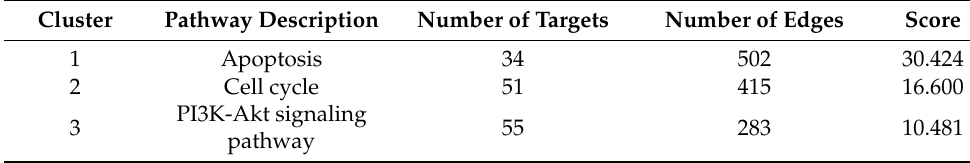
Table 2. Top 3 clusters identified from the MCODE results of